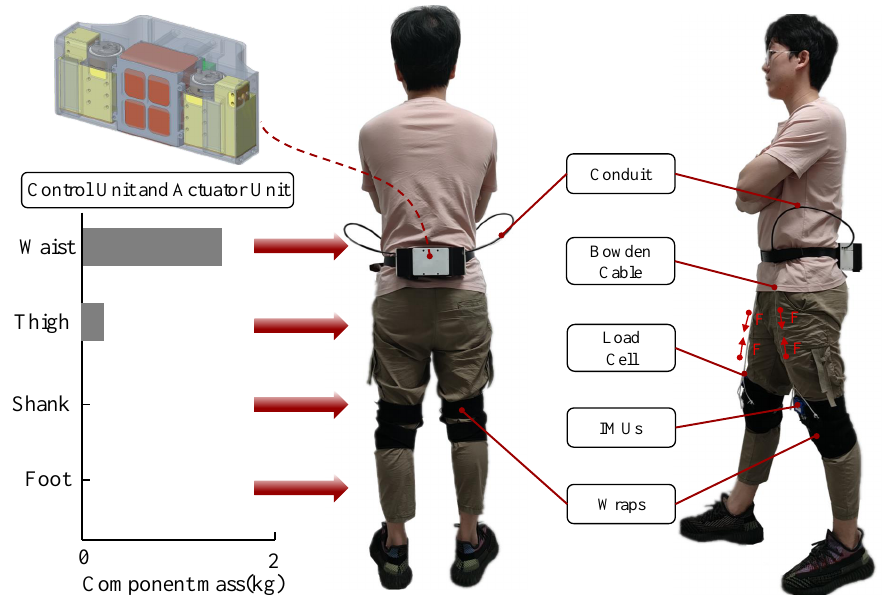
Figure 1. The lower limb lightweight soft exosuit. The whole system is worn on the waist and thighs of humans. The F represents the direction of assistance